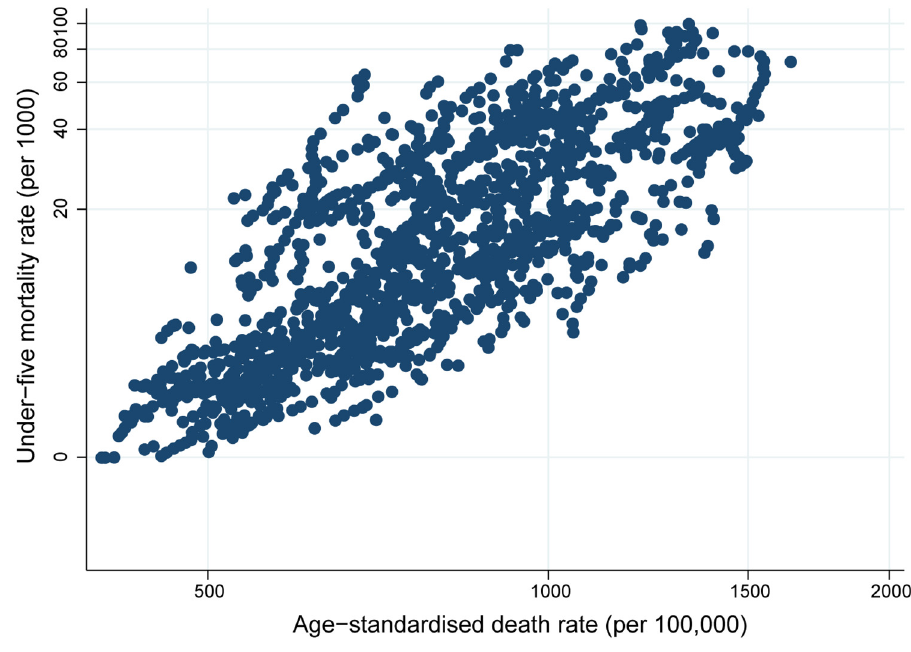
Fig 2. Under-five mortality rate by age-standardised death rate (both log scale), 108 countries, 1990–2015.